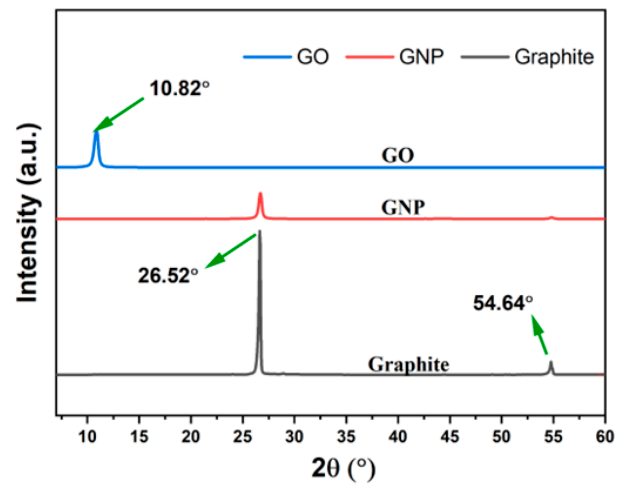
Figure 4. XRD pattern of GNPs and GO in comparison with pure graphite.